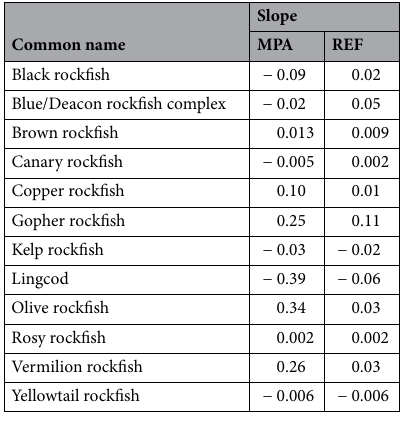
Table 2. The rate of change in biomass (biomass per unit effort; BPUE) of the 12 species most commonly caught during surveys along the Central coast region for MPA and Reference (REF) sites following the MHW. Negative values indicate a decline in biomass, positive values indicate an increase in biomass, and values close to zero indicate no